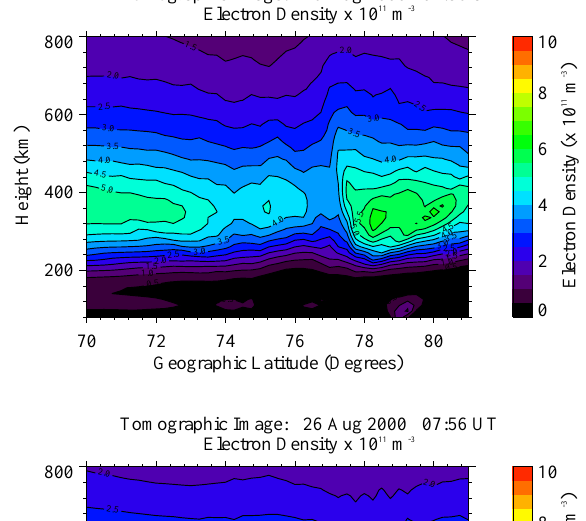
Fig. 4. Plot showing the geometry of the observations on a MLAT versus MLT polar grid. The location of the ESR radar beam during successive radar scans is shown broadly between 09:00–13:00 MLT with labels indicating the starting position of the first (1) and last (9) radar scan. Also shown are the trajectories of three northbound NIMS satellites at 07:36 UT, 07:56 UT and 08:26 UT where the arrows indicate the direction of satellite motion. The dusk-to-dawn trajectory of the DMSP F13 satellite is shown by the thick hori- zontal black line, with the black arrow at the pre-noon extent of the trajectory indicating the direction of satellite motion. The white triangle with a small black shaded region superimposed on the satel- lite trajectory broadly between 10:00–11:00 MLT indicates the ex- tent of the ion dispersion signature and region of cusp precipitation, respectively.